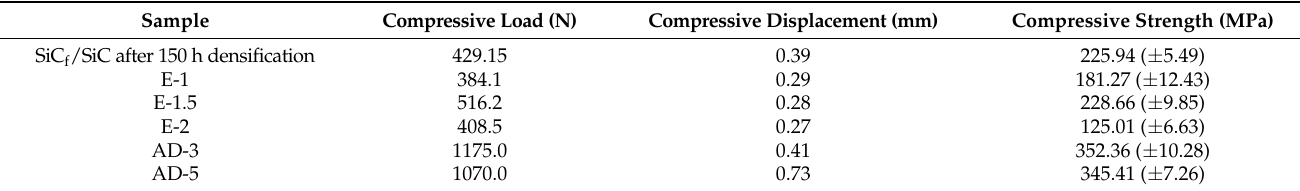
Table 2. Mechanical properties of SiC f /SiC composites prepared by EP and AD